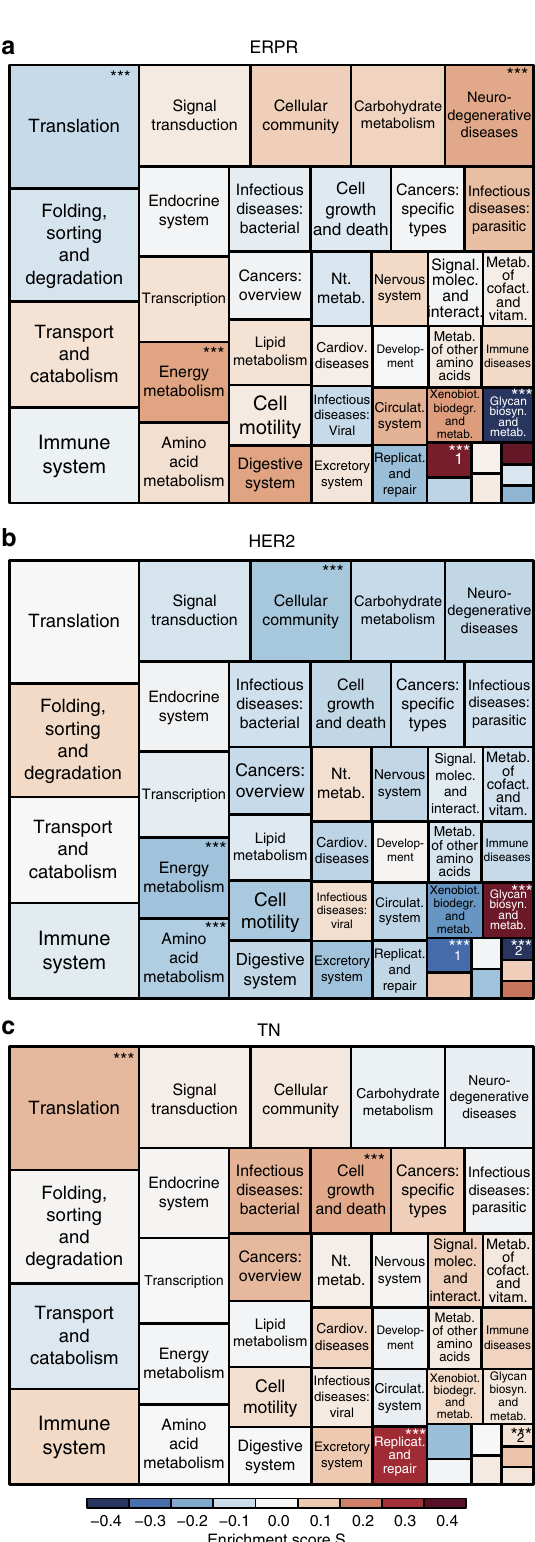
Figure 3 | Tree-maps of subtype-specific KEGG categories. Enrichment of breast cancer subtype-specific KEGG pathways is shown for ERPR ( a ), Her2 ( b ) and TN ( c ) breast cancer subtypes. Each Tree-map includes all KEGG pathways mapped to a high hierarchical level. The size of the boxes corresponds to the number of proteins in that category and the color—to the enrichment score S, computed with the one dimensional enrichment test. Categories in red are characterized by higher average expression in the corresponding subtype, and in dark blue—by lower average expression. The categories that are significantly enriched at FDR 5% are indicated by ***. Category ‘1’ stands for ‘global and overview maps’ and category ‘2’—for ‘biosynthesis of other secondary